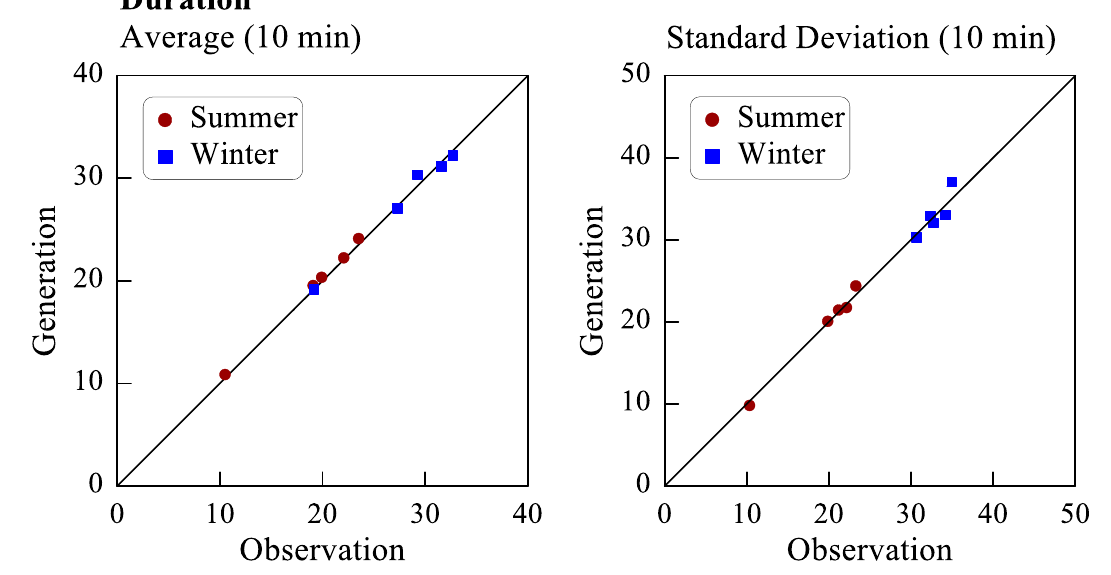
Figure 11. Comparison of the average and standard deviation values obtained for the observed and generated rainfall duration.